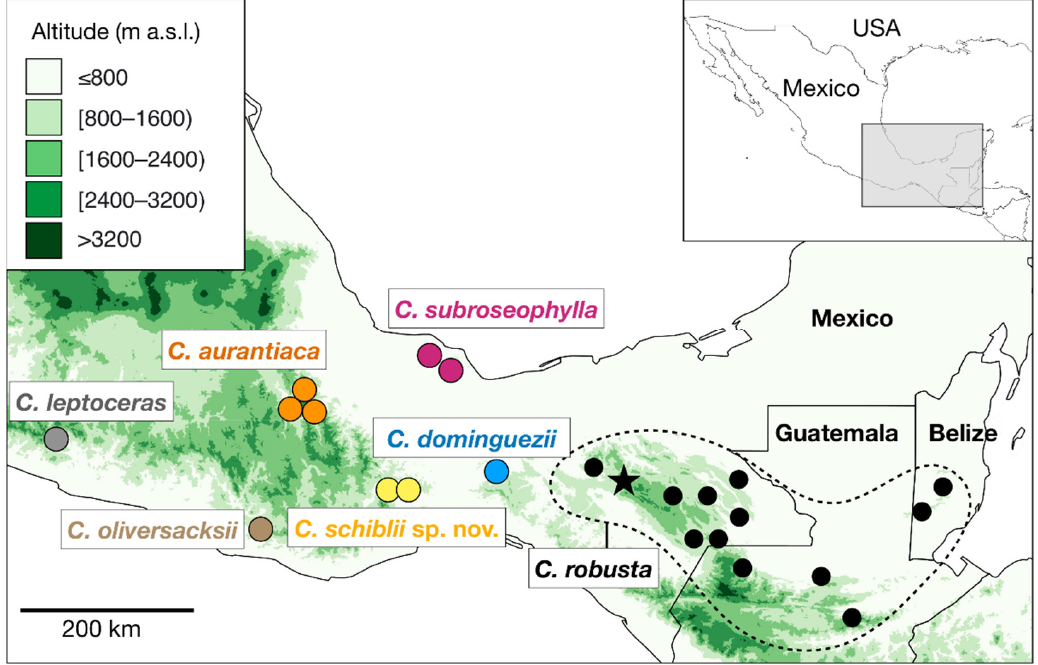
Figure 1. Distribution map of the known populations of the seven species in the Ceratozamia robusta species complex. The figure is updated from our previous studies [8,9]. The putative new species from eastern Oaxaca ( C. schiblii sp. nov.) occurs near the center of the distribution range and is represented by yellow circles. Black circles surrounded by a dotted line indicate the occurrence of populations of C. robusta , the species with the widest distribution in the complex. The star symbol indicates the neotype locality of C. robusta (Parque Nacional Cañón del Sumidero, Chiapas, Mexico). The species C. aurantiaca , C. subroseophylla , C. dominguezii , C. oliversacksii, and C. leptoceras are also part of the species complex. Green color scale indicates the elevation in meters above sea level (m